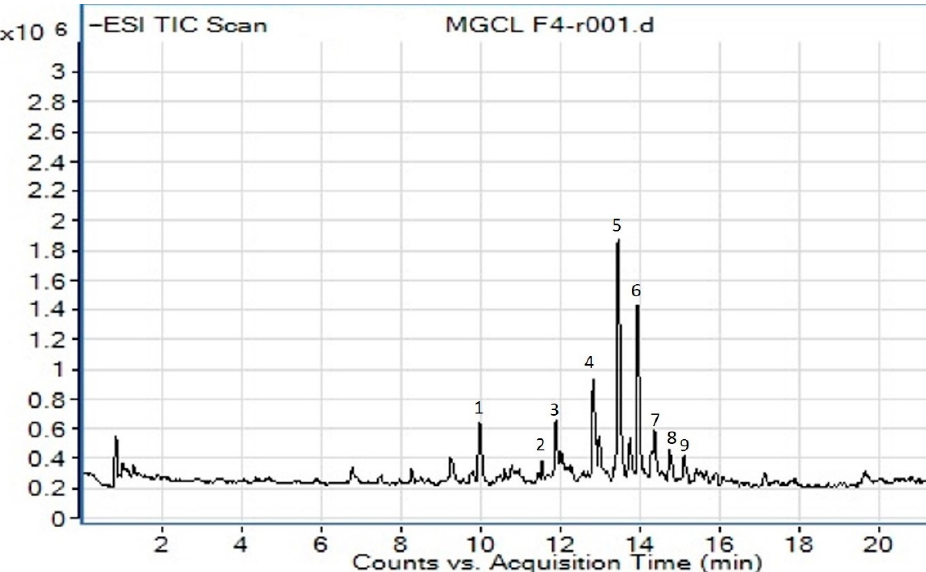
Figure 1. The total ion chromatogram of M. glabra chloroform leaves’ crude fraction CF4 obtained from LC-MS/MS under negative ion mode. Compounds are numbered based on retention times (RT). The x -axis is the retention time, and the y -axis is the intensity of the 𝑚 / z peaks. Table 3. The phytoconstituents were putatively identified in fraction CF4 of M. glabra chloroform leaves.